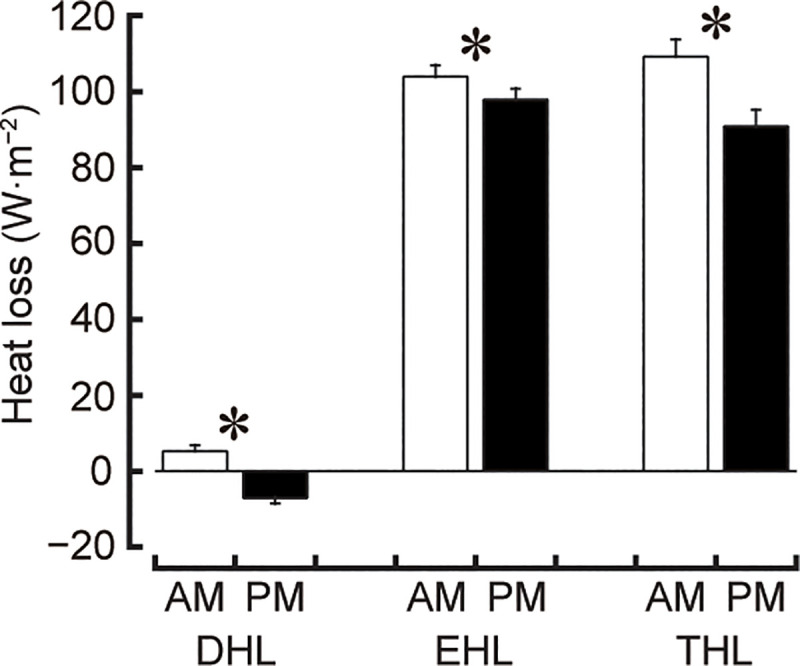
Responses of dry (DHL), evaporative (EHL) and total (THL) heat losses at the skin during exercise.*P<0.001 denotes a difference between AM and PM trials.